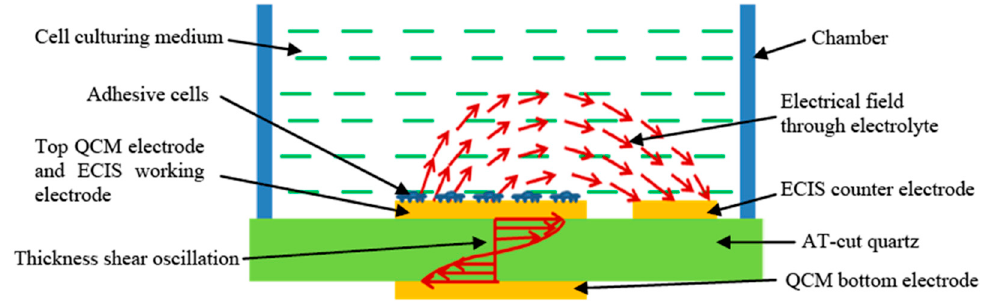
Figure 8. Illustration of the working principle of the hybrid biosensor which integrates the acoustic wave sensing with impedance spectroscopy technique [81].